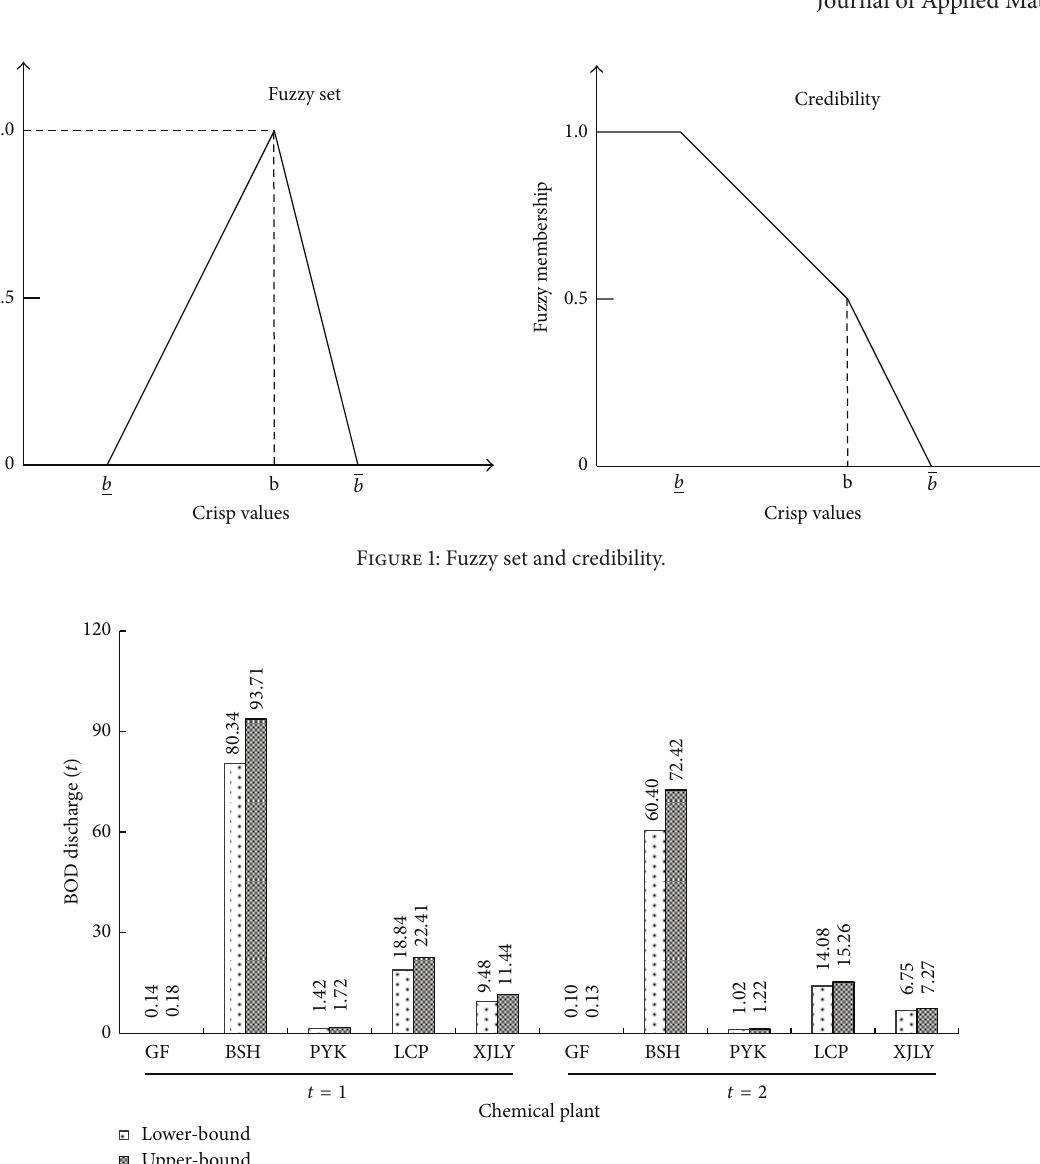
Figure 2: BOD discharges from chemical plants. Note: the five chemical plants are abbreviated as their initials in this figure. GF: Gufu, 𝑖 = 1 ; BSH: Baishahe, 𝑖 = 2 ; PYK: Pingyikou, 𝑖 = 3 ; LCP: Liucaopo, 𝑖 = 4 ; XJLY: Xiangjinlianying, 𝑖 = 5